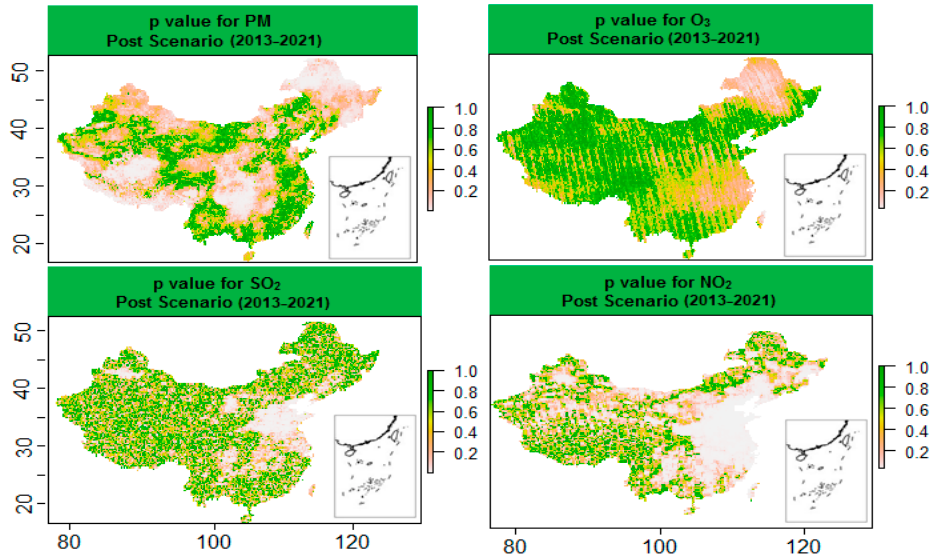
Figure 7. p value of air pollutants for the post-scenario period (2013–2021). Note: Mann Kendall p -value at 95% confidence ( p < 0.05).